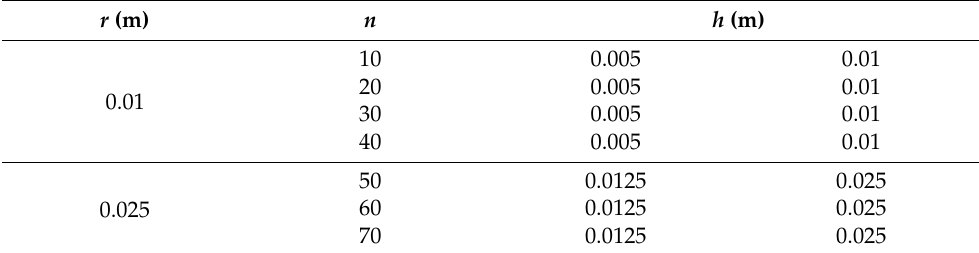
Figure 3. A numerical model with a pair of coils Tx-Rx: ( a ) a WPT cell geometry, ( b ) a grid over the entire area, ( c ) a grid over coils. Table 1. Geometrical parameters of the analyzed models of WPT